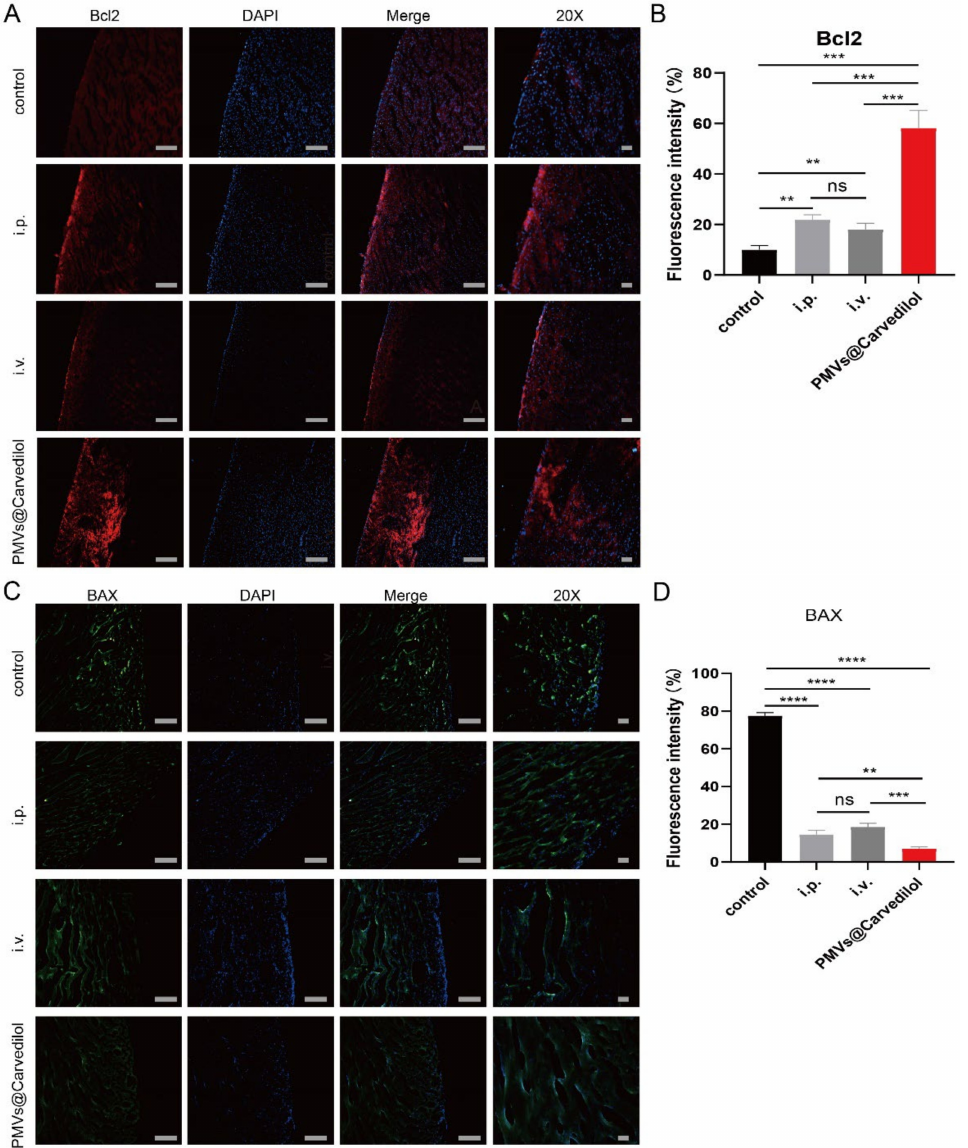
Figure 7. PMVs@Carvedilol therapy reduces myocyte cell apoptosis. ( A ) Expression of antiapoptotic molecule Bcl2 under immunofluorescence. Scale bar, 600 µ m; 20 × Scale bar, 150 µ m. ( B ) Quantitative analyses of antiapoptotic molecule Bcl2. ( C ) The expression of apoptotic molecules Bax under immunofluorescence. Scale bar, 600 µ m; 20 × Scale bar,150 µ m. ( D ) Quantitative analyses of apoptotic molecule Bax. (i.p. means intraperitoneal injection; i.v. means intravenous injection.) ** p < 0.01; *** p < 0.001; **** p <